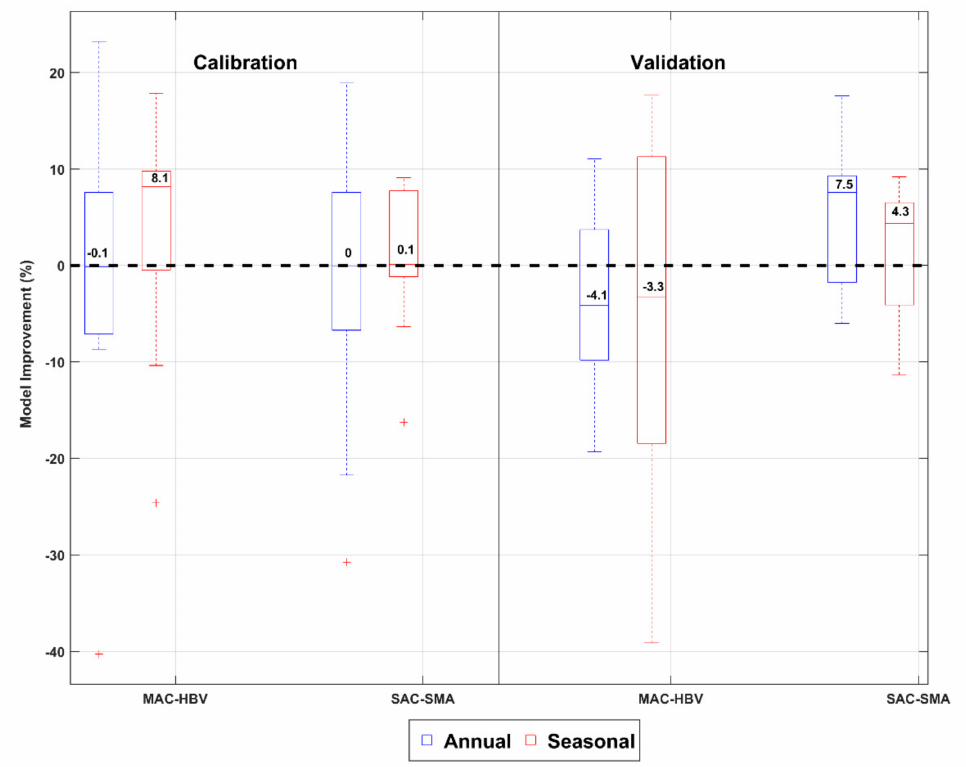
Figure 3. Model Improvement (defined by % reduction in RMSE) obtained by using the SNOW-17 model instead of DDM for LGRB. Positive values mean model improvement when coupled with the SNOW-17 model, while negative values mean model deterioration due to implementation of the SNOW-17 model (with DDM taken as a base model for evaluation). Boxes are delimited by the 25th and 75th percentiles, the median value is printed in the boxes, and the whiskers are delimited by 10th and 90th